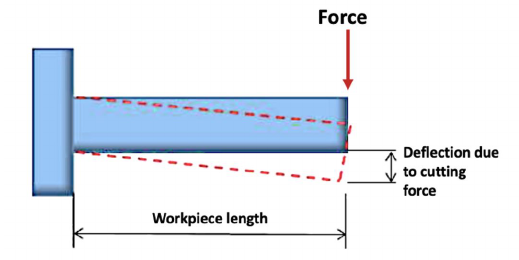
Table 1. Machining condition of